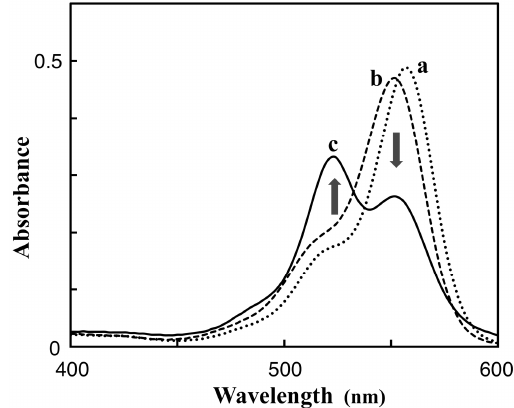
Sensors 2017 , 17 , 1877